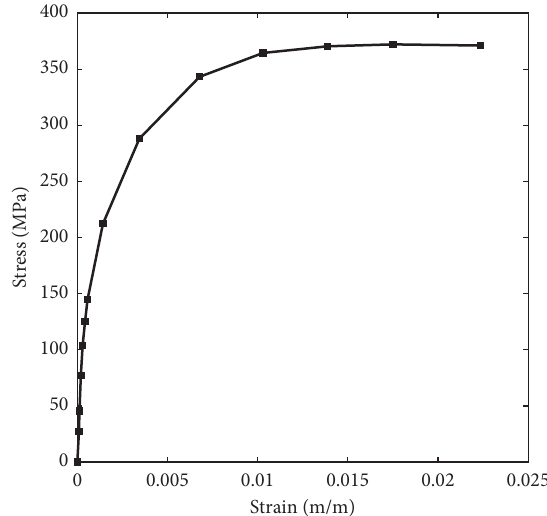
Figure 13: Stress-strain diagram for CuCD RHP3434 obtained from the four-point bending